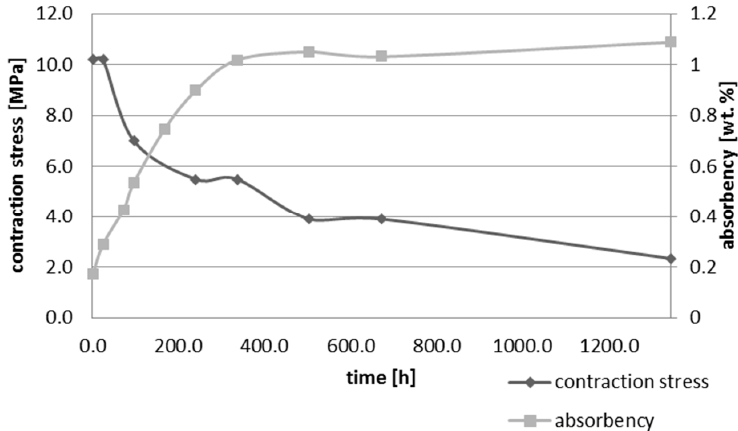
Figure 3. The influence of water sorption (28 days water immersion) on absorbency and contraction stress generated during photopolymerization of Filtek Ultimate.